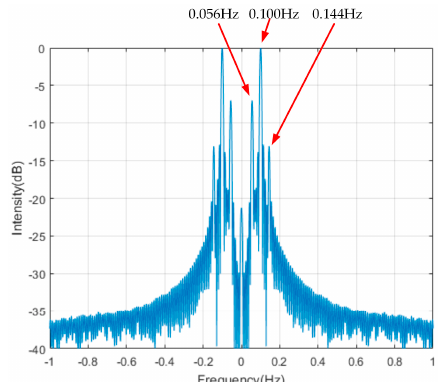
Figure 8. The echo signal in the Doppler domain.